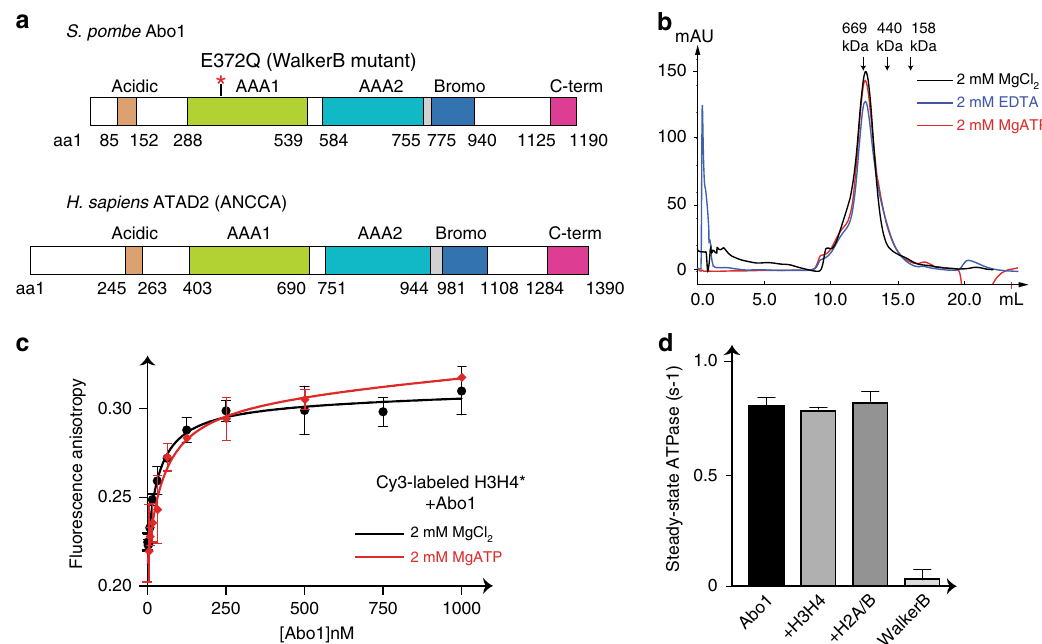
Fig. 1 Recombinant Abo1 is an ATPase that binds histone H3 – H4. a Conserved domain organization of S. pombe Abo1 and human ATAD2. We term the region between the AAA2 domain and bromodomain (shown in gray) the “ linker arm ” based on structural data shown below (Fig. 3b, c). b Gel fi ltration pro fi le of Abo1 over a Superose6 column under different buffer (2 mM EDTA, 2 mM MgCl 2 , and 2 mM MgATP) conditions. c Binding of Abo1 to Cy3- labeled H3 – H4 measured by fl uorescence anisotropy assays. The Kd of Abo1 is 23 ± 13 nM. Error bars represent the standard error of the mean (SEM) for three experiments with different preparations of protein. d Steady-state ATPase rate of Abo1 in the presence of histone substrates. Error bars represent SEM for three experiments with different preparations of